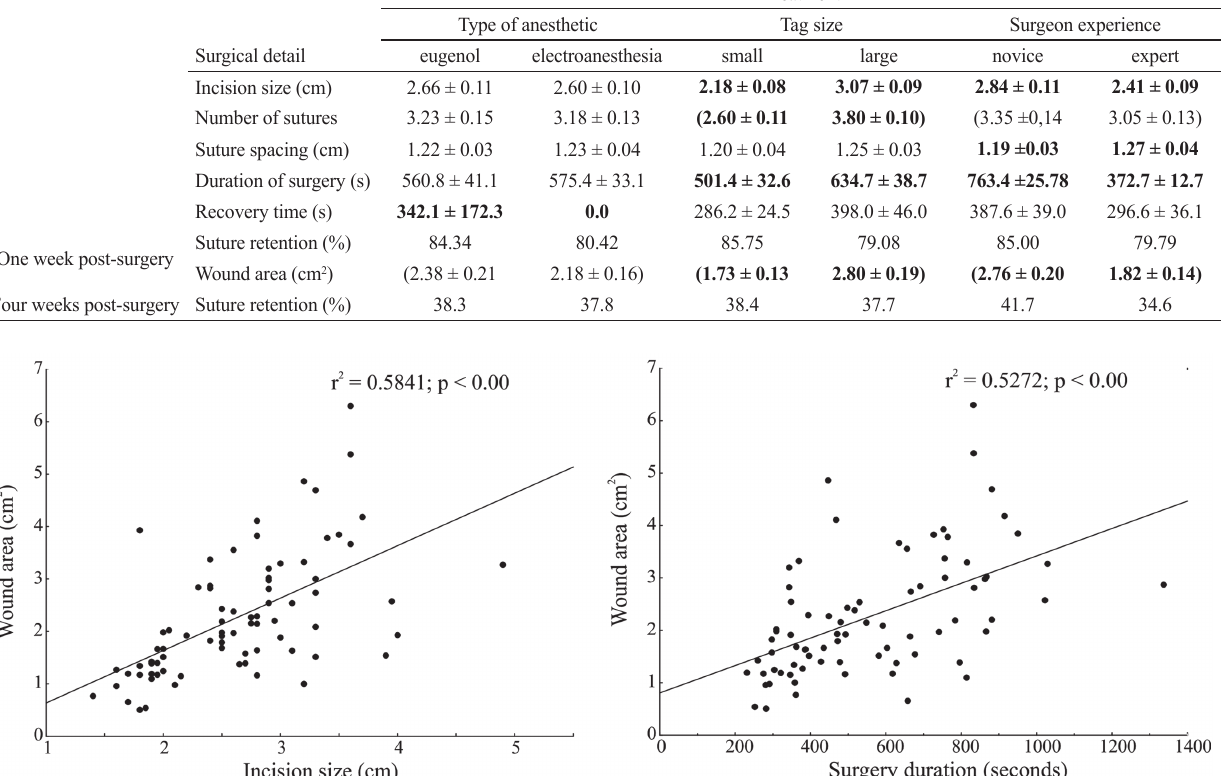
Fig. 4. Effect of incision size (cm) and duration of surgery (s) on wound area (cm 2 ) one week after surgical implantation of telemetry transmitters in Prochilodus lineatus .